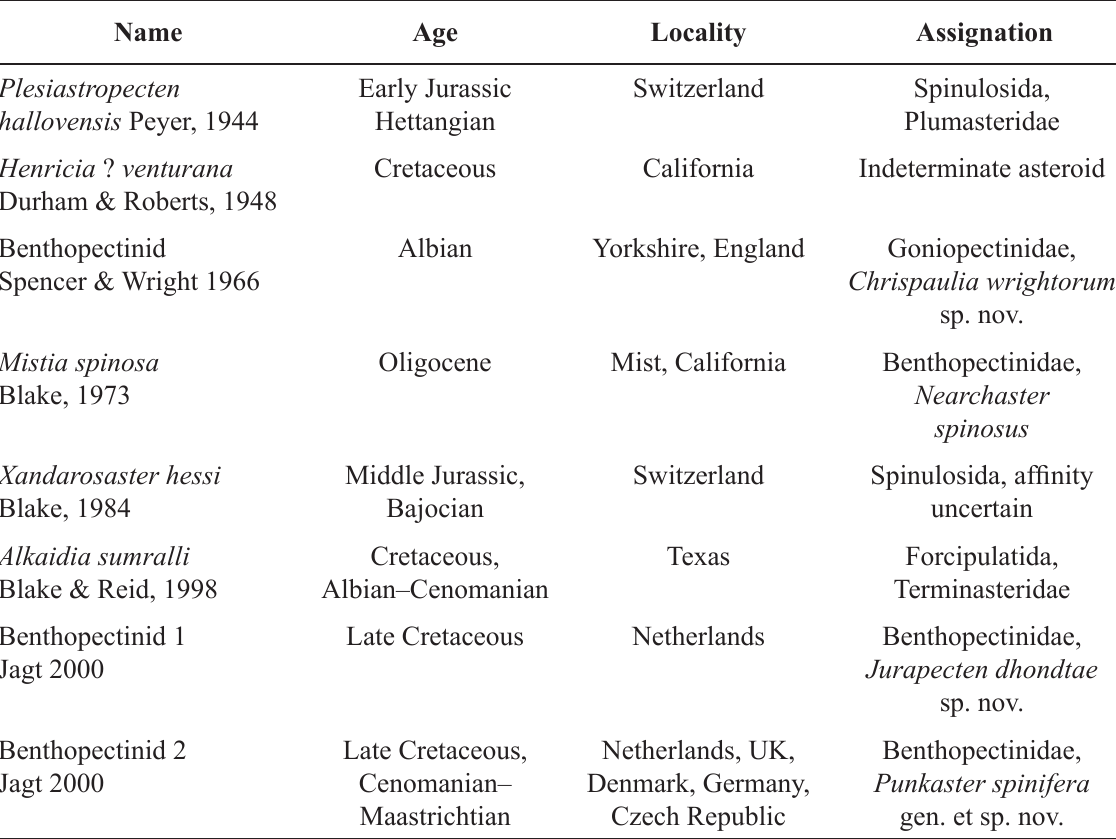
Table 2. Affinities of fossils assigned to the Benthopectinidae Verrill, 1894, by date of